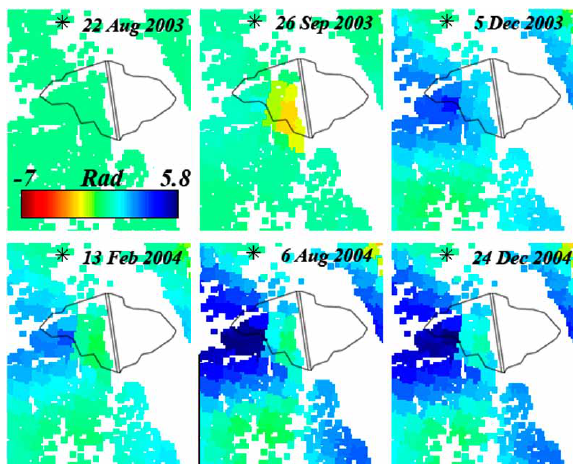
Fig. 4. Main unwrapped interferograms due to master